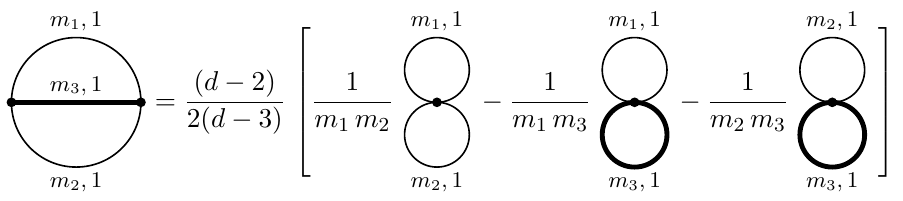
Figure 2 . Visualization of the factorization of a two-loop integral with unit propagator powers into a basis of one-loop tadpoles, as given in eq. (2.14) (see also eq. (3.19)). The graphical notation is as in figure